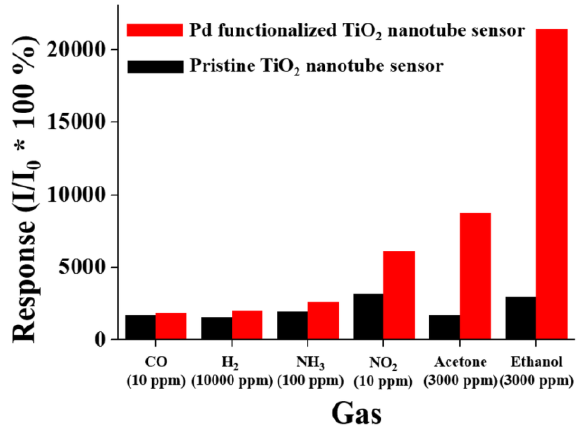
Figure 12. Comparison of the responses of pristine and Pd-functionalized TiO 2 nanotubes to different gases. Reproduced with permission from [115].